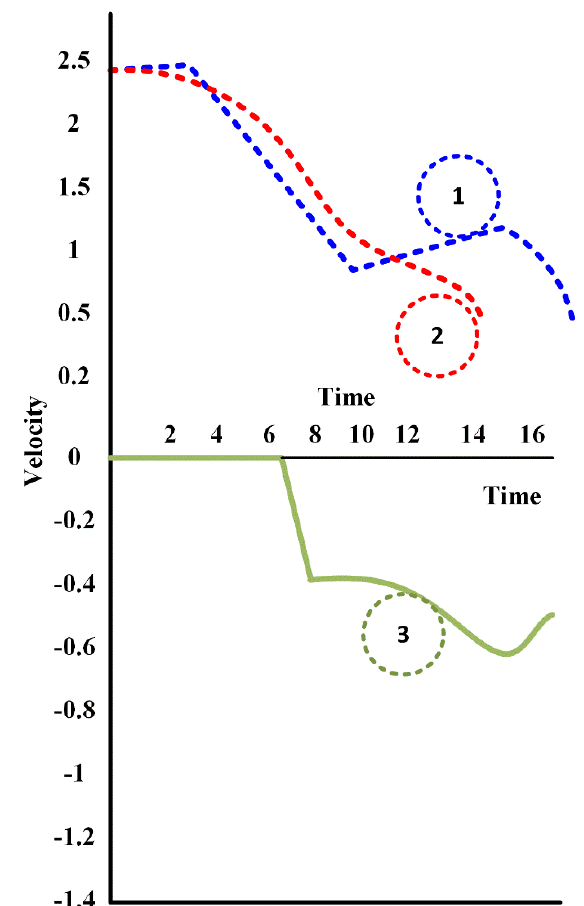
Figure 17. Characteristics of velocity when valves are closed.